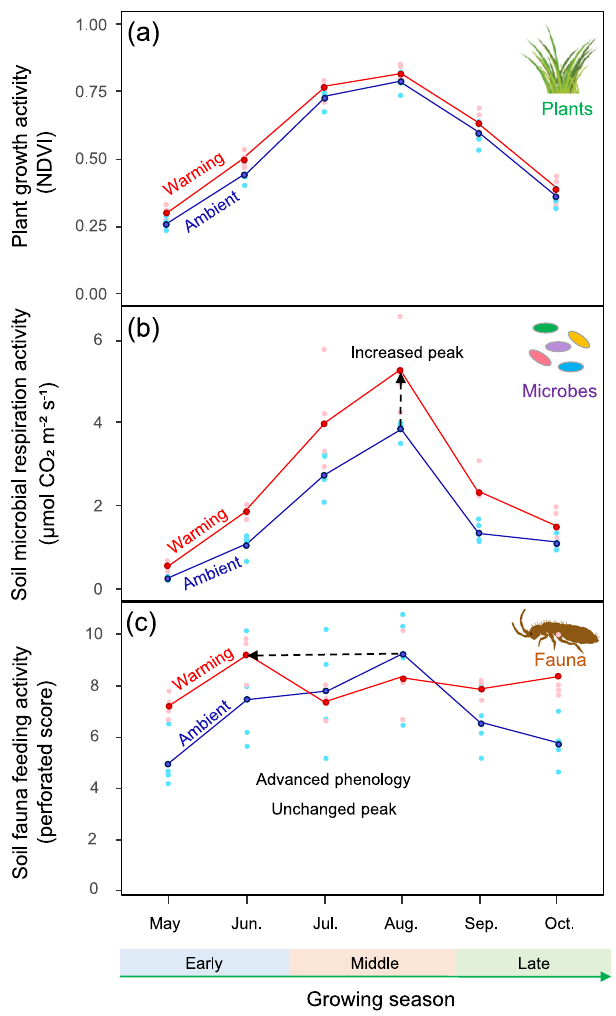
Fig. 3 | Phenology of activities of plants, soil microbes, and soil fauna during the growing season under ambient vs. warmed climate conditions. Warming increasedthepeakvaluesofplantgrowthandsoilmicrobialrespirationactivitiesin the middle of the growing season without much shifts in their phenology ( a , b ). Warmingadvancedspring phenologyand delayedautumnphenologyofsoilfauna feeding activity, with an unchanged activity peak during the growing season ( c ). Themonthlyaverageactivitiesoftheseorganismswereconnectedbystraightlines (with the corresponding colored sampling points, n =4) for both ambient